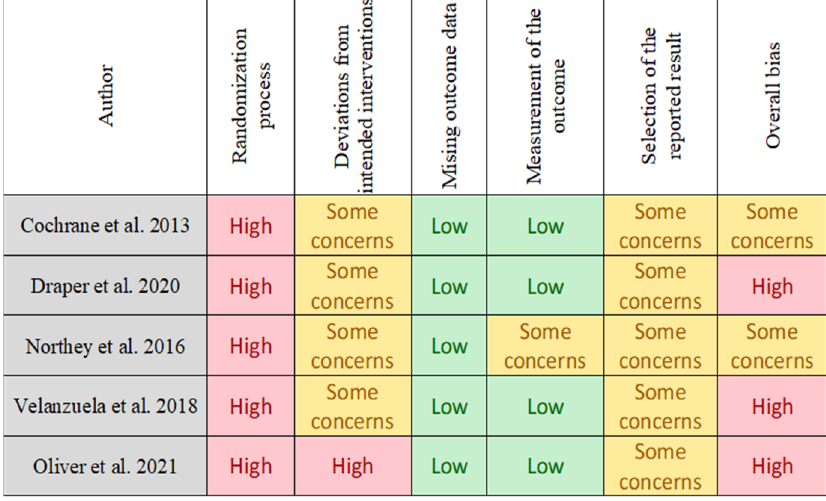
Figure 2. Risk of bias 2 tool. Assessment for individually randomized, cross-over trials [25].